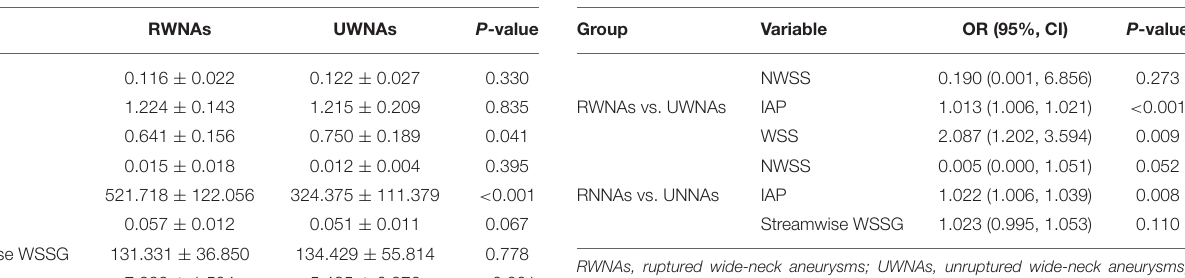
TABLE 6 | The results of binary logistic regression analysis for WNAs and